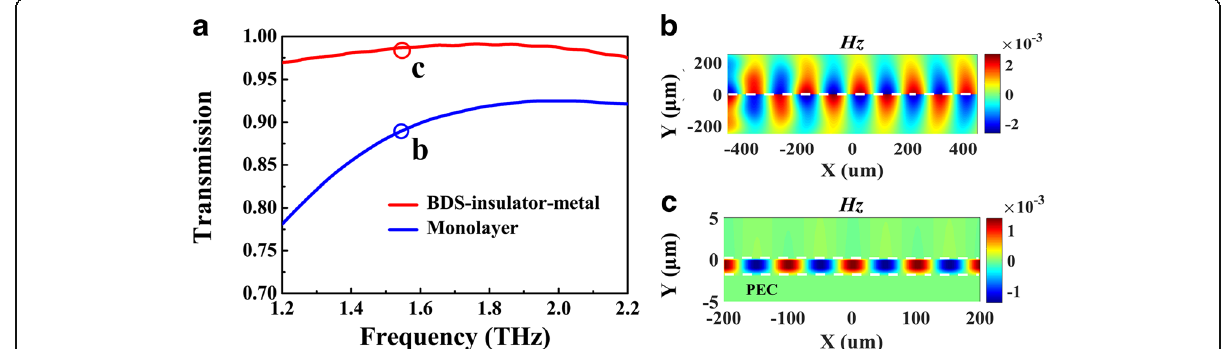
Fig. 3 Numerical calculations of the transmission spectra ( a ) and magnetic field ( H z ) distributions ( b , c ) of BIM (red curve) and monolayer (blue curve) waveguides, where E